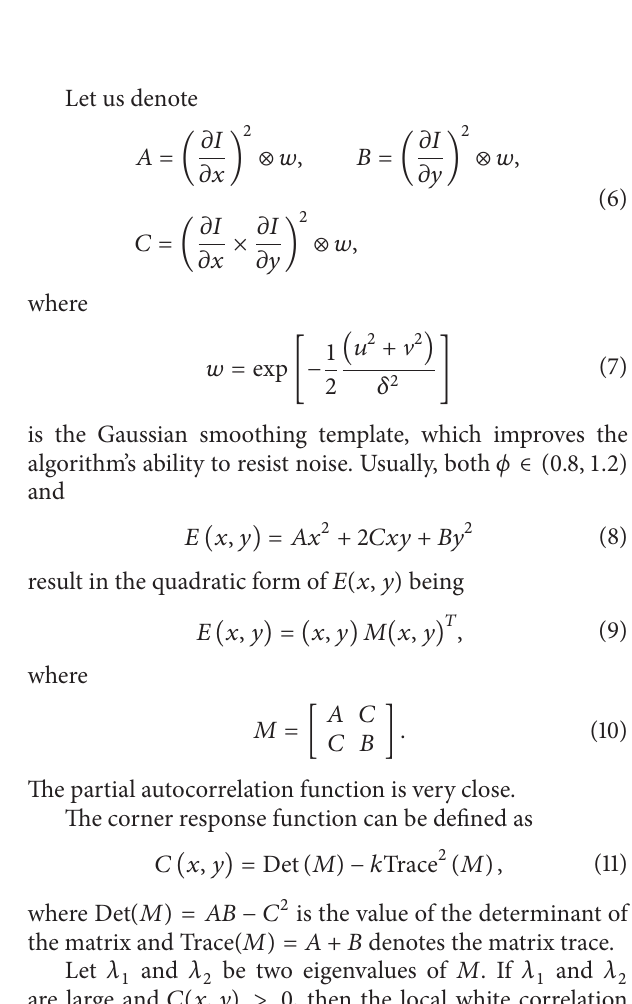
Figure 3: Processing results before and after application of the Harris corner detection algorithm: (a) original hard disk image; (b) hard disk image processed by the Harris